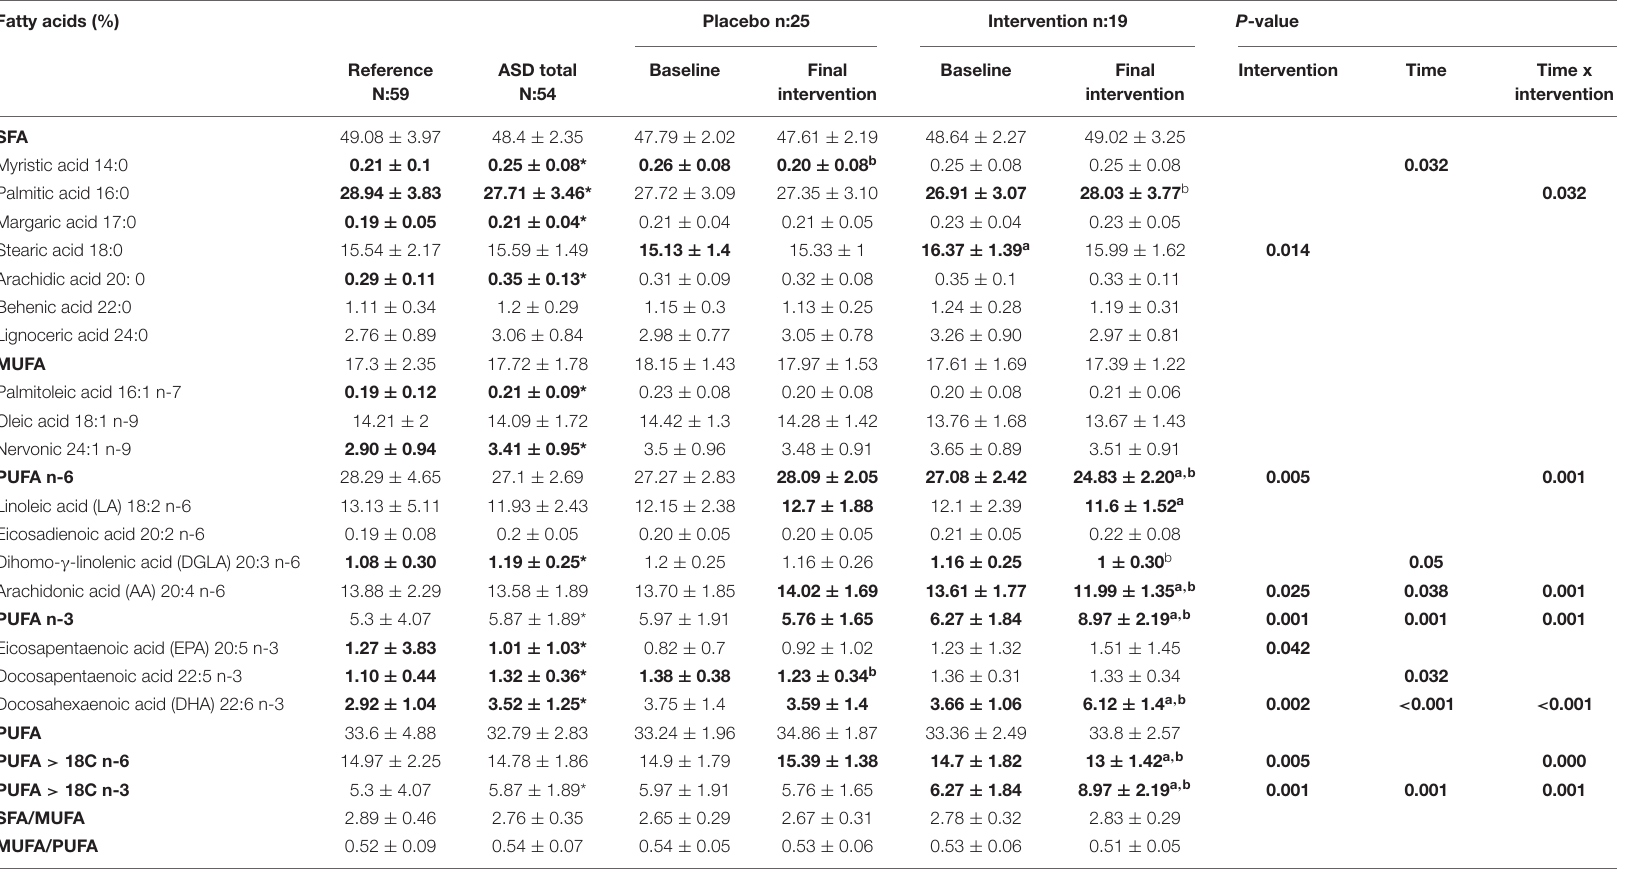
TABLE 4 | Comparison of fatty acid profile in erythrocytes profile between reference group and ASD children. Fatty acids (%) Placebo